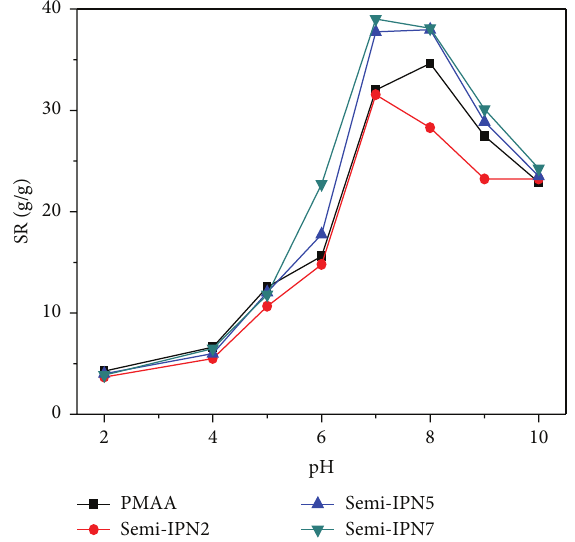
Figure 4: The swelling ratio of the hydrogels in different pH value buffer